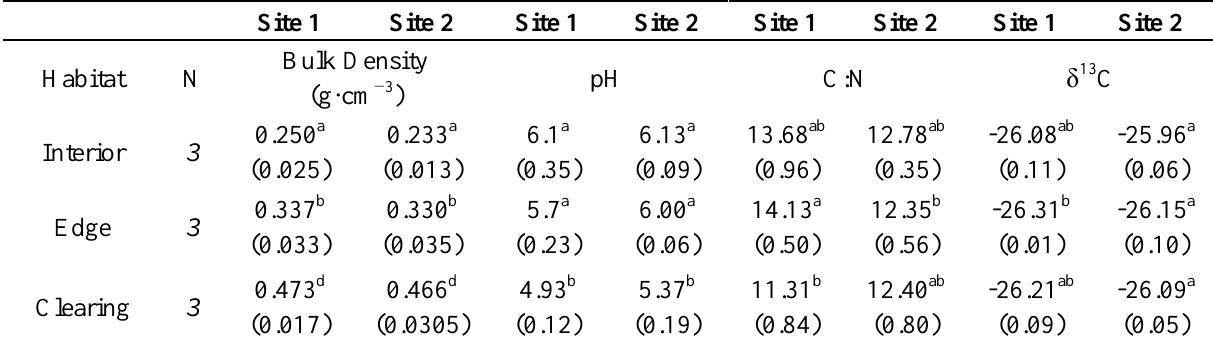
Different lower case letters indicate significant differences in a nutrient among habitats within a site and asterisks indicate significant differences between sites ( p = <0.05) using one-way ANOVA and student’s